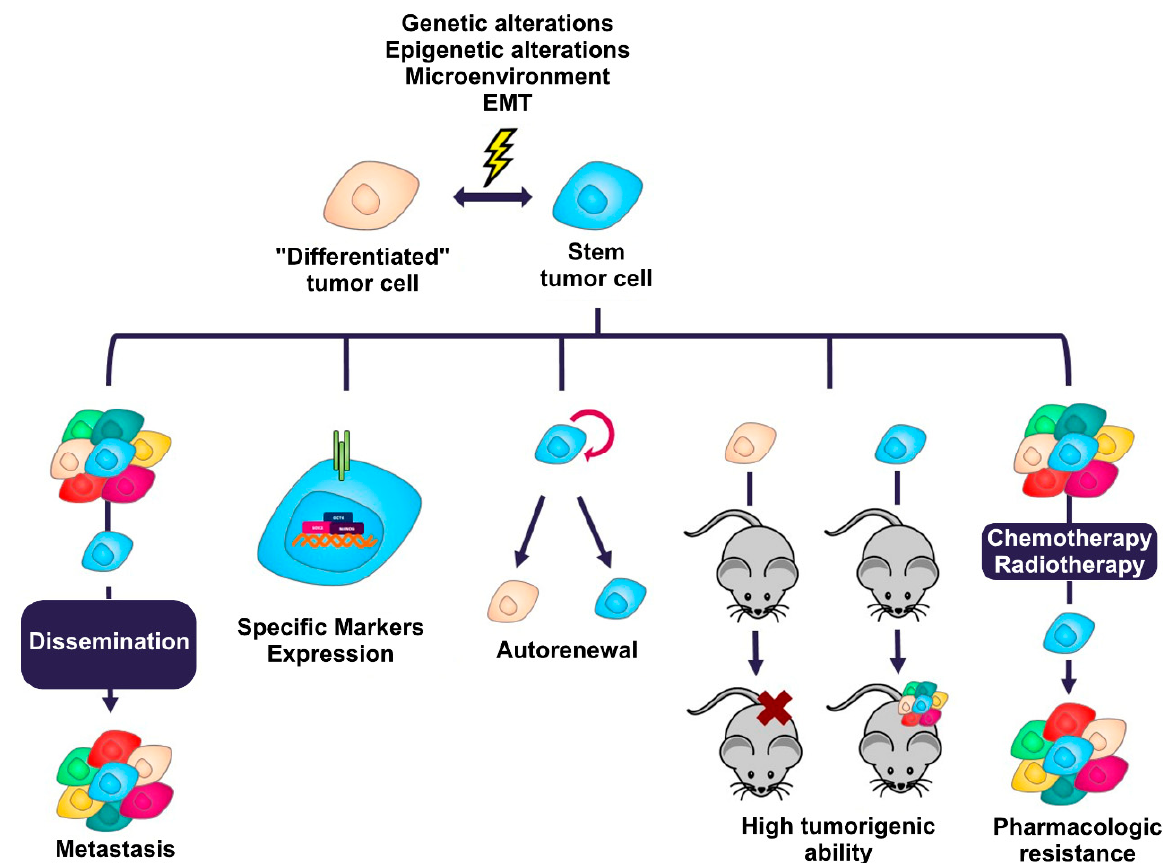
Figure 1. Characteristics that define the stem phenotype in cancer. Cancer cells can transition between a state of stemness and non-stemness generated by multiple genetic and epigenetic alterations, the tumor microenvironment, and the activation of signaling programs such as EMT. These processes allow cancer cells to acquire the ability to metastasize, express membrane proteins or specific intracellular molecules, self-renew, have a high tumorigenic capacity in vivo, and generate resistance to many conventional cancer treatments.